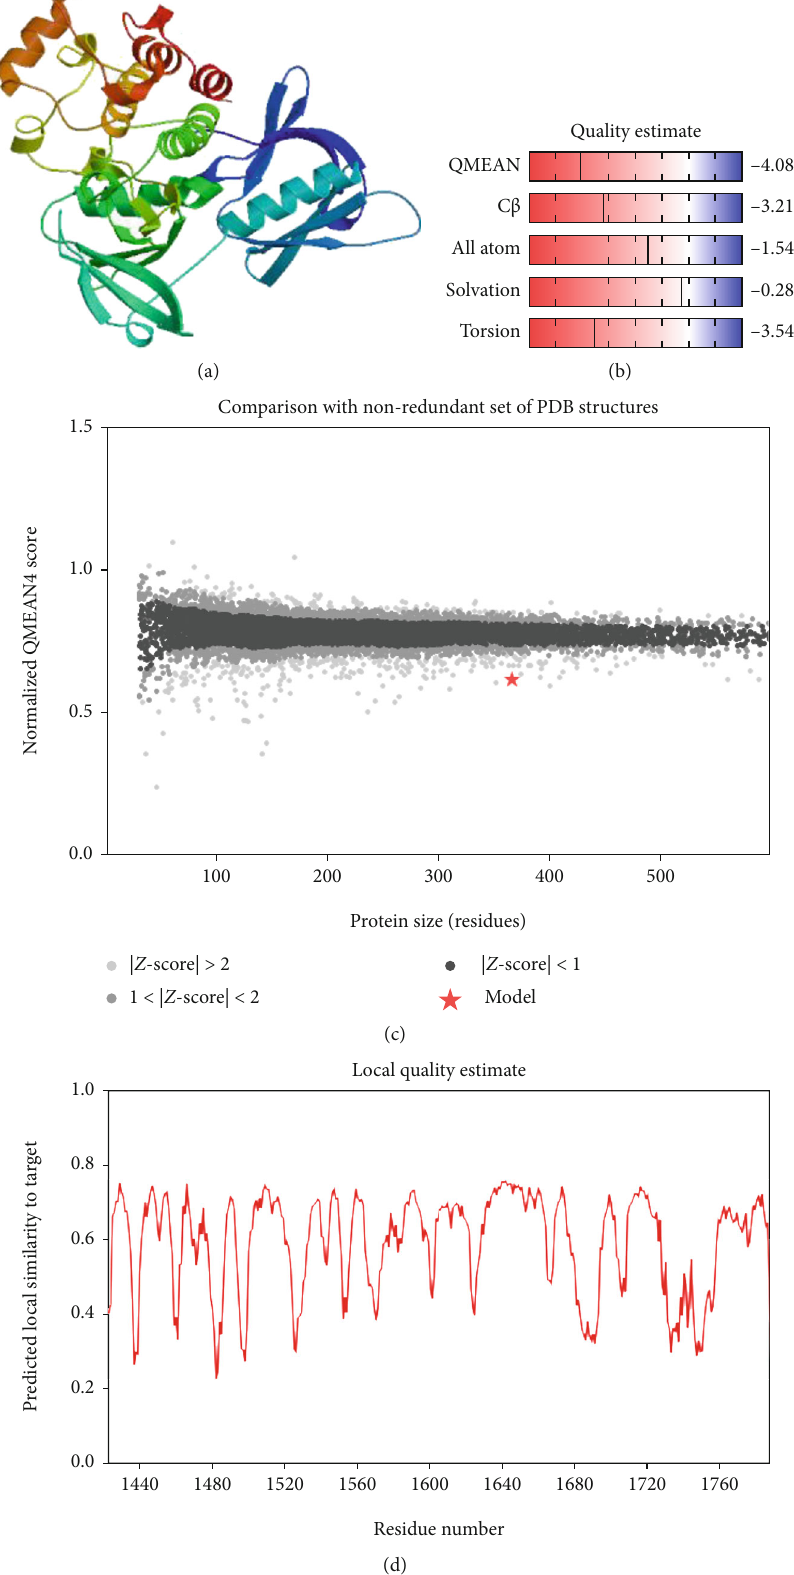
Figure 4: SWISS-MODEL server output. (a) Computed 3D model; (b) global quality estimate; (c) comparison with nonredundant set of PDB structures; (d) local quality